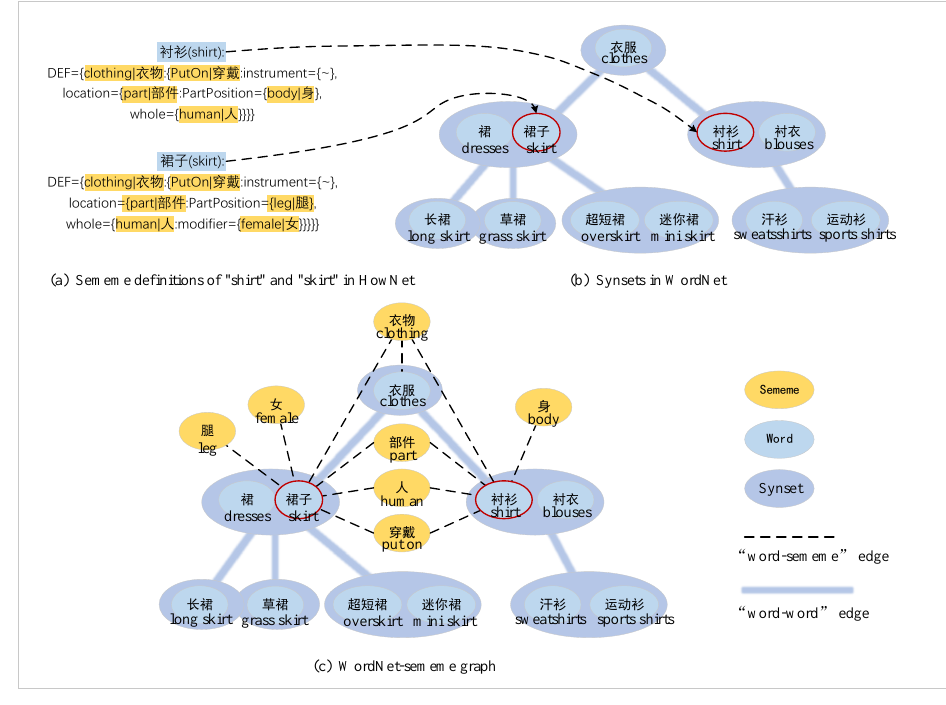
Figure 1. The construction process of WordNet–sememe